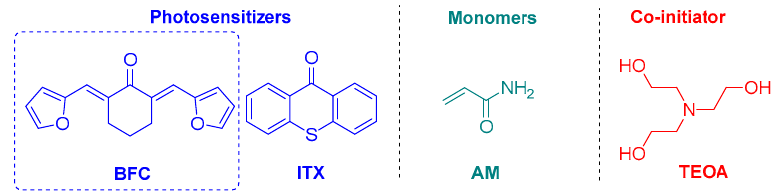
Figure 9. Chemical structures of BFC, ITX, AM, and TEOA.